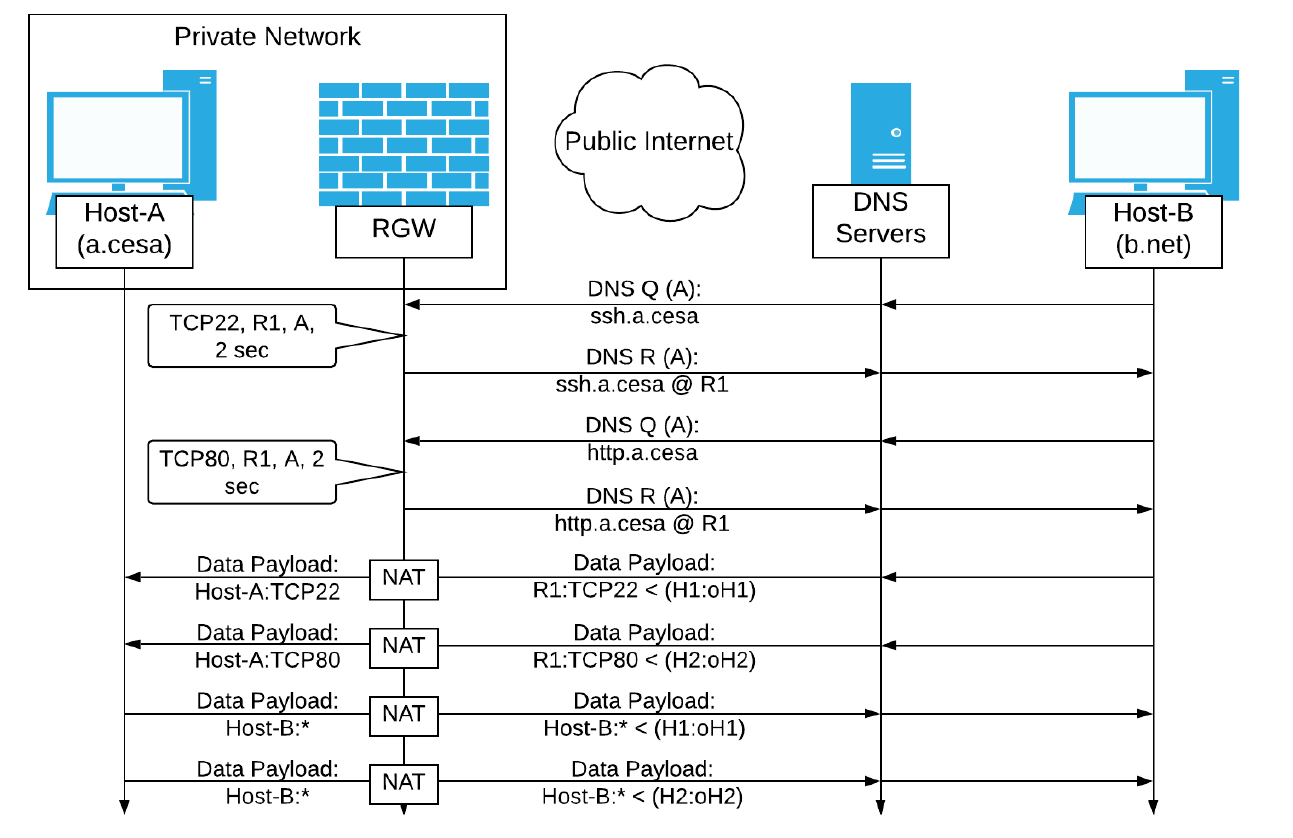
Figure 6. CETP signaling–scenario with RGW (oCES-Outbound CES, iCES-Inbound